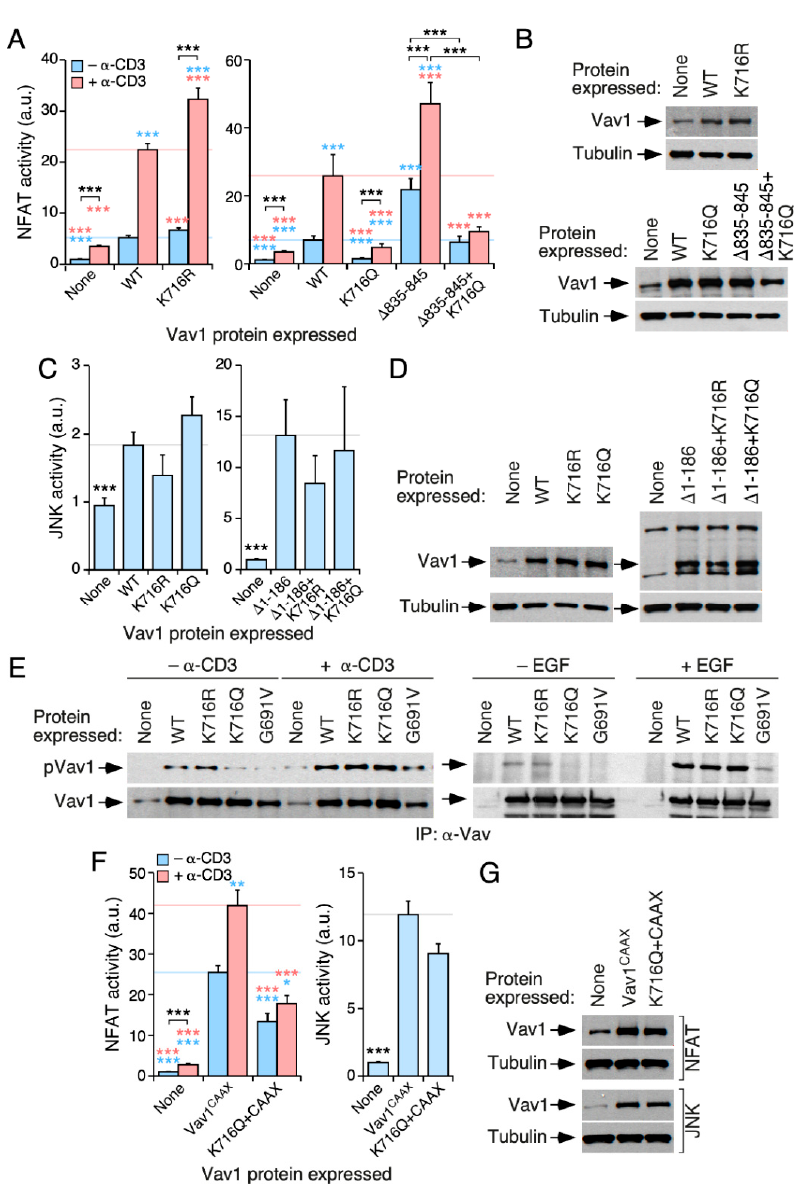
Figure 5. The acetylation of Lys 716 impairs the activation of NFAT by Vav1. ( A , C ) Activation of NFAT ( A ) and JNK ( C ) by the indicated Vav1 proteins in nonstimulated and TCR-stimulated Jurkat cells. Data and P values are depicted as in Figure 3E ( n = 3 independent experiments, each performed in triplicate). ( B , D ) Representative immunoblots showing the abundance of the indicated Vav1 proteins in the experiments shown in A ( B ) and C ( D ). Endogenous tubulin α was used as loading control in all cases. (E) Levels of tyrosine phosphorylation of the indicated Vav1 proteins immunoprecipitated